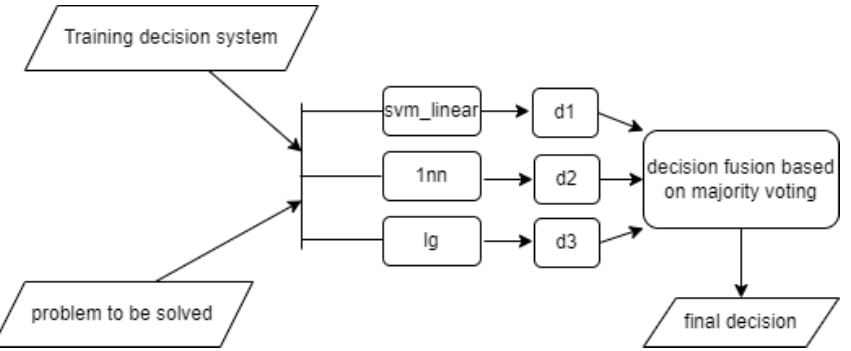
Figure 7. Visualisation for device bee 3: Squared the average reading in classes 0 and 1; bee 3.2 and bee 3.3 ( left ) and ( right ), respectively.